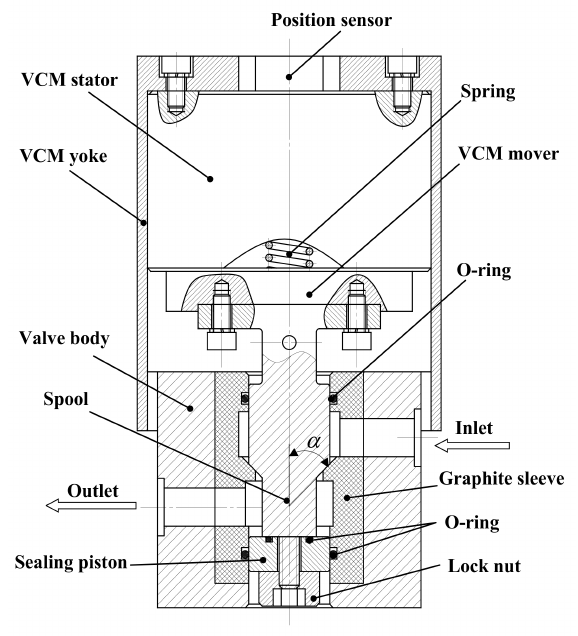
Figure 1. Schematic diagram of the developed high-speed pneumatic on/off valve